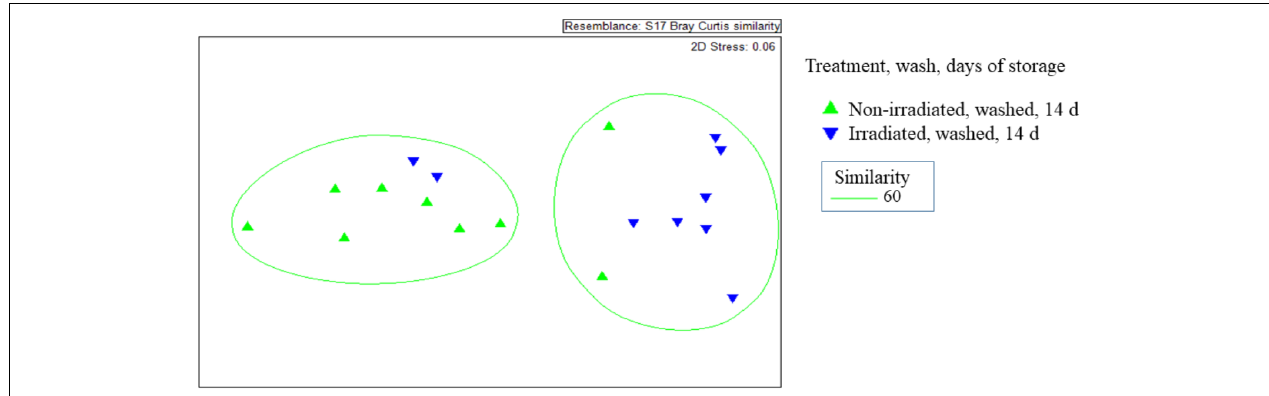
FIGURE 5 | Non-metric multidimensional scales of Bray-Curtis distance matrices of ARGs found on irradiated and non-irradiated, sodium hypochlorite washed lettuce surfaces on day 14 of storage. Each point represents one lettuce sample ( (cid:72) irradiated and washed, n = 9) and each ( (cid:78) non-irradiated and washed; n = 9). ANOSIM, R = 0.406, p = 0.008 indicates distinct ARG profiles between non-irradiated and irradiated lettuce stored at 4 ◦ C for 14 days. TABLE 3 | Average relative abundance of ARGs on unprocessed and processed lettuce at Day 14. Treatment ARG class